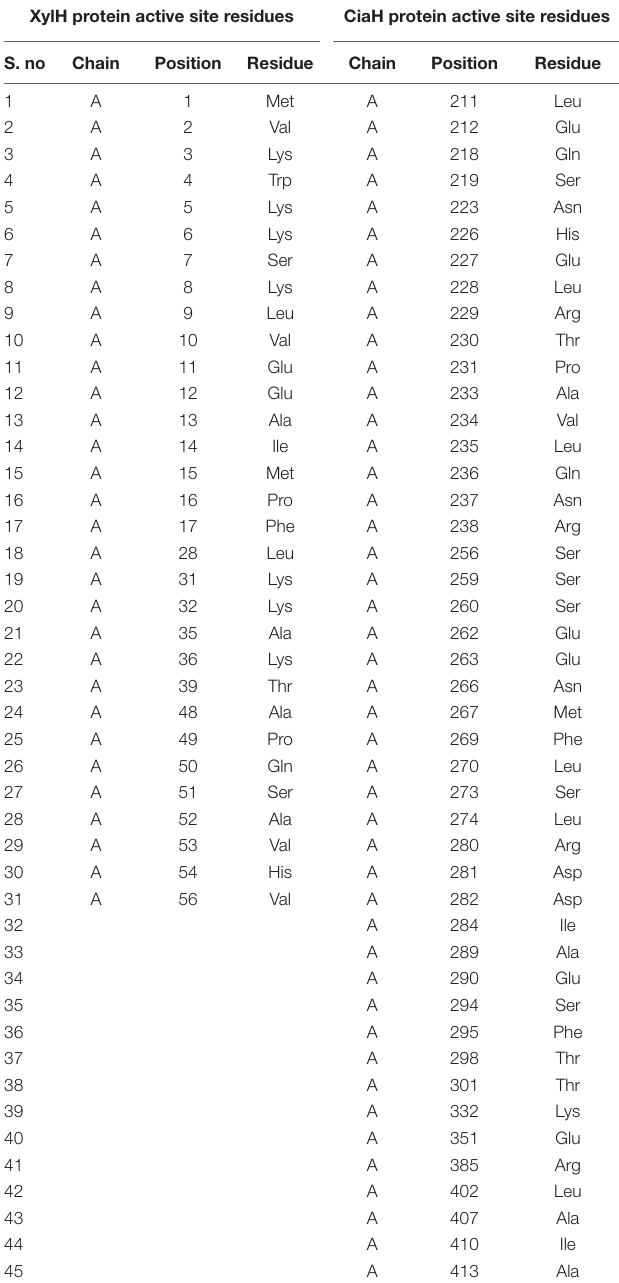
TABLE 5 | Active site: Residues present in the Active site of XylH and CiaH protein. XylH protein active site